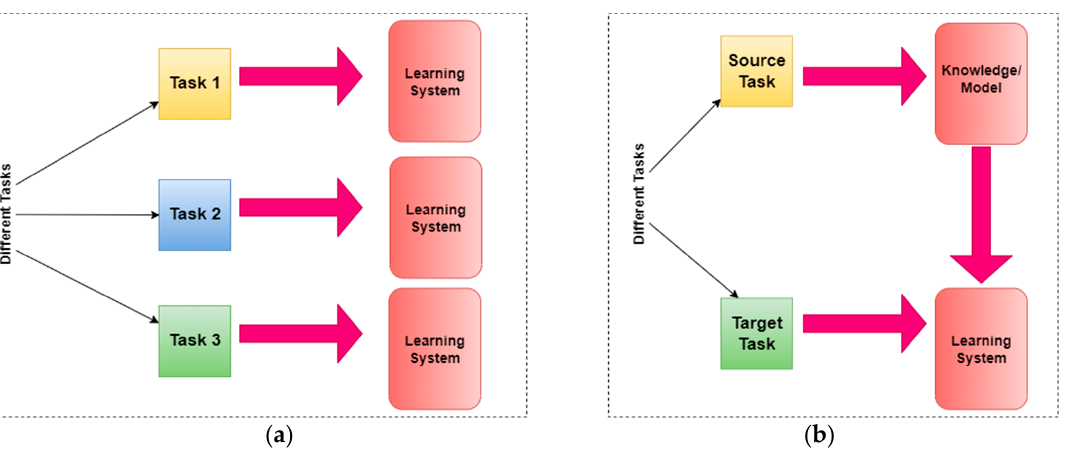
Figure 6. An example of the difference between the traditional ML approach and the TL method [66], where Figure ( a ) shows the task and ( b ) represents the target related knowledge.